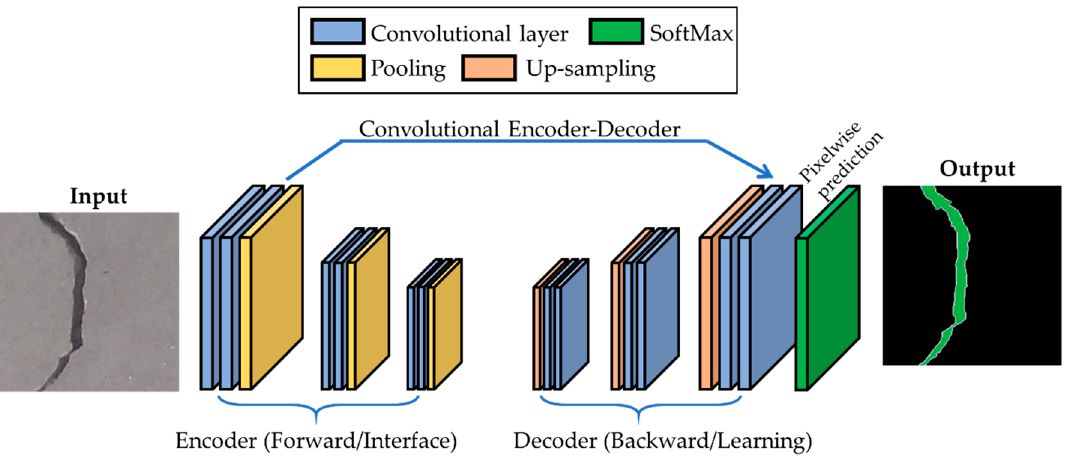
Figure 1. Block diagram of the proposed fully convolutional network (FCN) with the encoder–decoder framework.